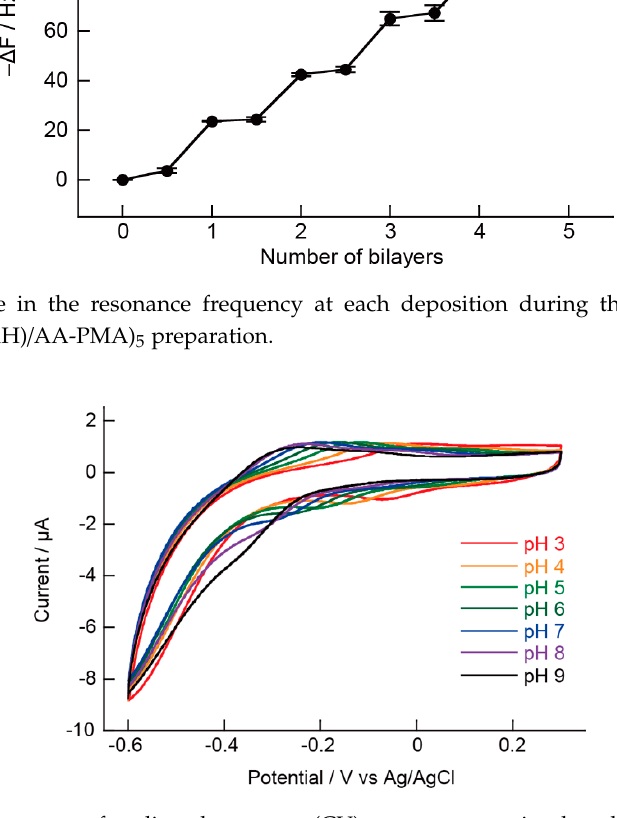
Figure 3. Change in the resonance frequency at each deposition during the (poly(allylamine hydrochloride) (PAH)/AA-PMA) 5 preparation.